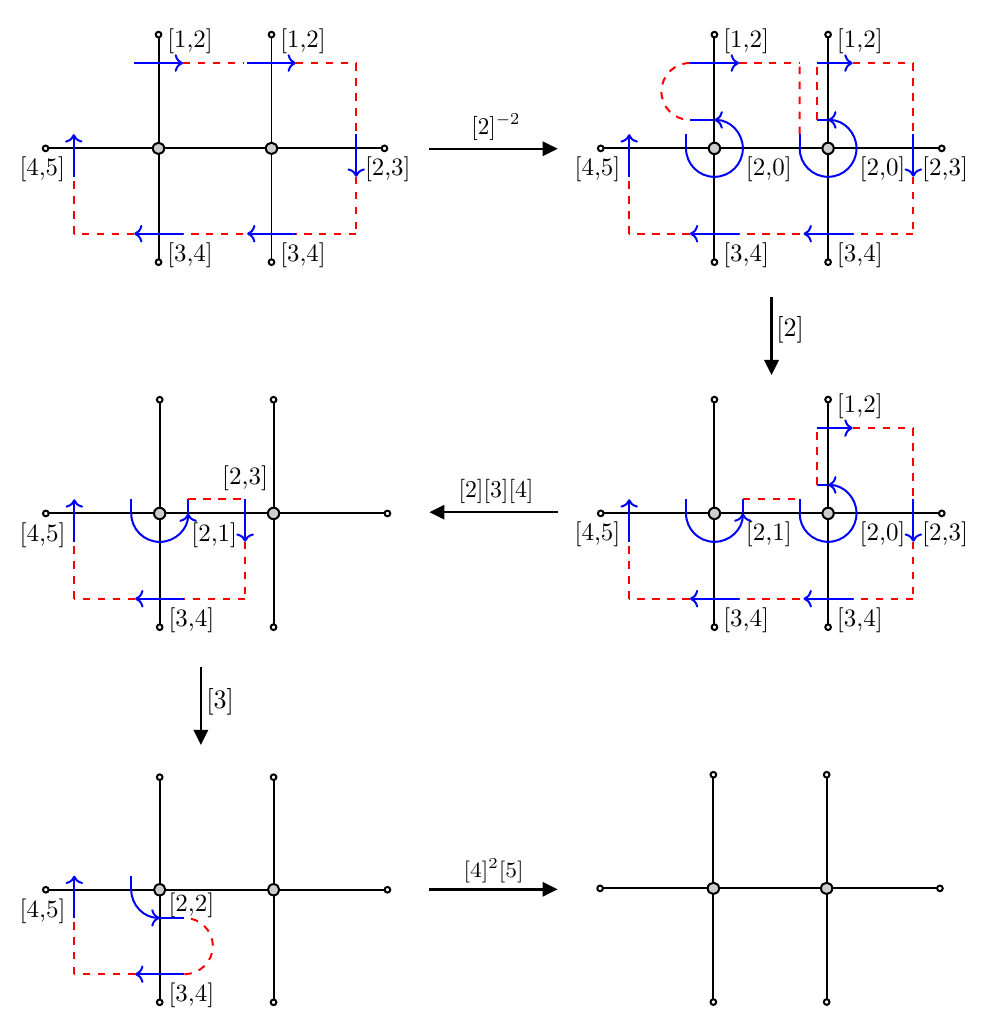
Figure 8 . The sequence of transformations of the monodromy acting onto the double cross integral. Numerical factors appearing in the process are indicated above the arrows.